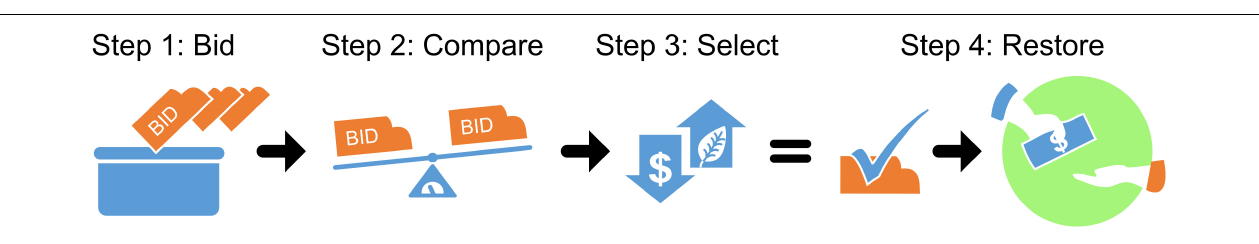
FIGURE 5 | We tested a conservation auction as a mechanism to incentivize wetland restoration on private land as part of the Living Laboratory